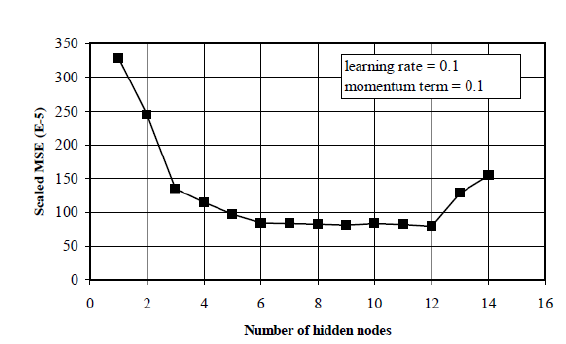
of hidden nodes, which was obtained in the previous step, are used in all of the training attempts of this step. The model is then retrained with different initial weights to investigate a better performance